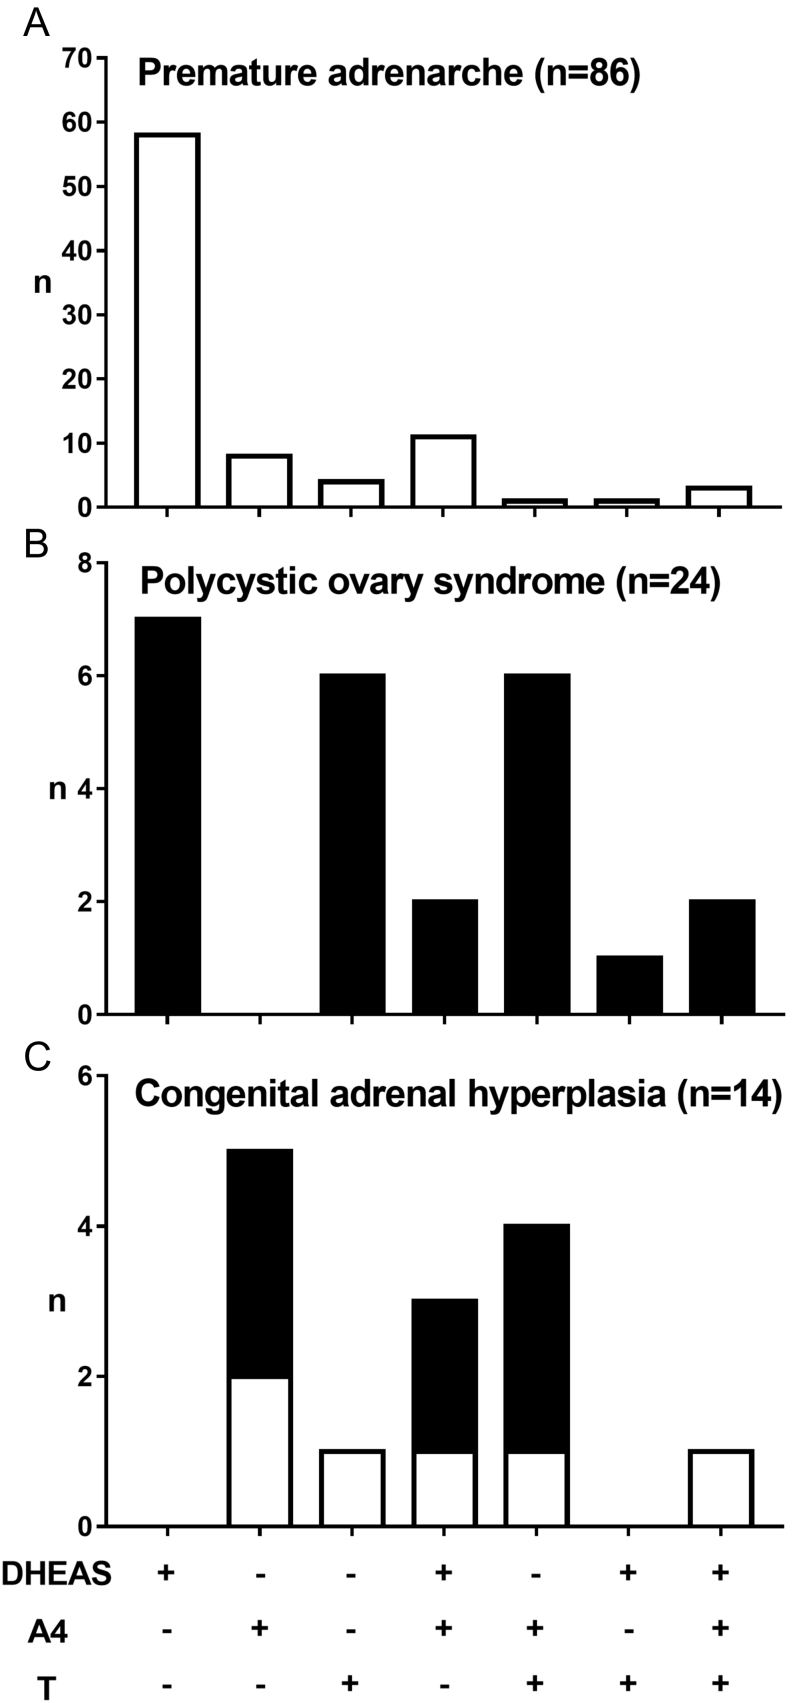
Distribution of serum androgen excess patterns in (A) children with premature adrenarche, (B) girls with polycystic ovary syndrome and (C) children with congenital adrenal hyperplasia. White bars represent pre-pubertal subjects, black bars post-pubertal subjects.